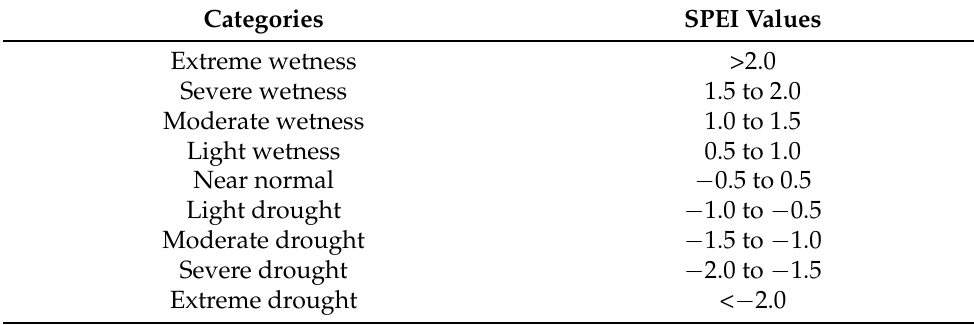
Table 1. The categorization of dryness–wetness grades based on the